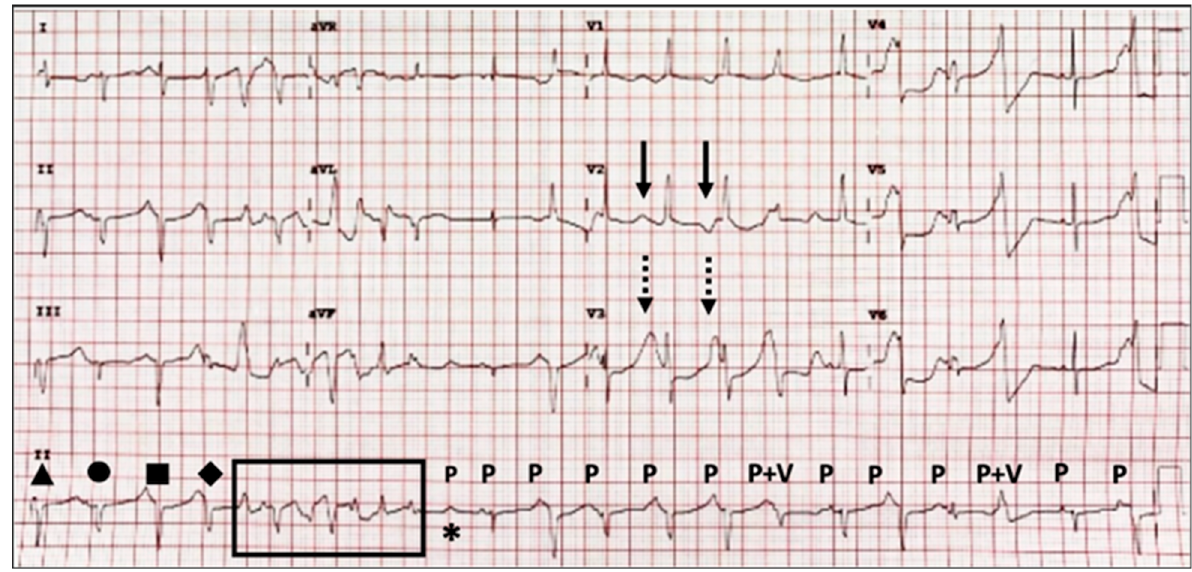
Figure 1. ECG on admission showing sinus rhythm with an extremely prolonged QTc interval of 623 ms under an HR of 127 bpm. The QRS morphology (triangle, circle, square, and diamond) and duration varied with T-wave alternans (arrows) and different T-wave morphologies (dotted arrows). The axis is northwest deviation. An AV block (asterisk), fusion beats (P + V), and non-sustained TdP (window) can also be observed. P, p wave; V,